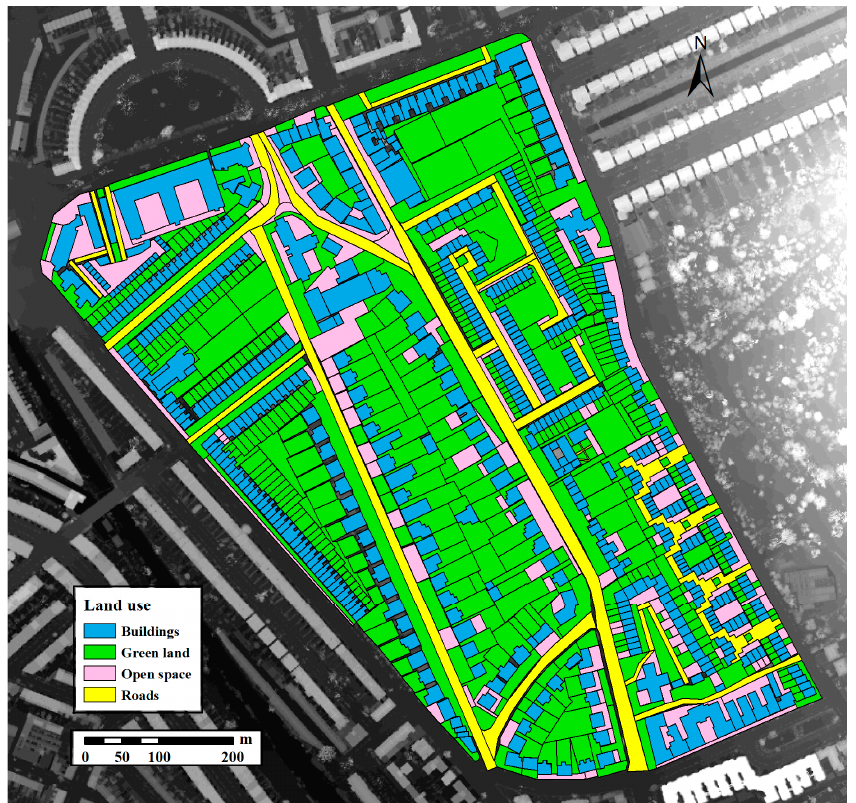
Figure 3. The land use map of the study area: blue polygons represent buildings; green polygons represent green land; pink polygons represent open space; yellow polygons represent roads.